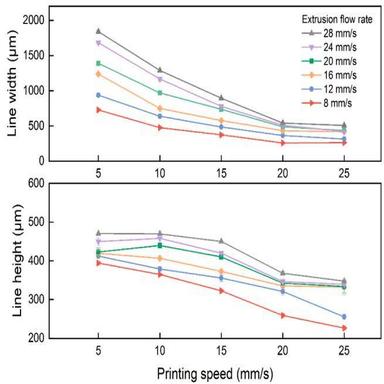
Correlation between the line width and printing speed and extrusion flow rate (top); correlation between the line height and the printing speed and extrusion flow rate (bottom).